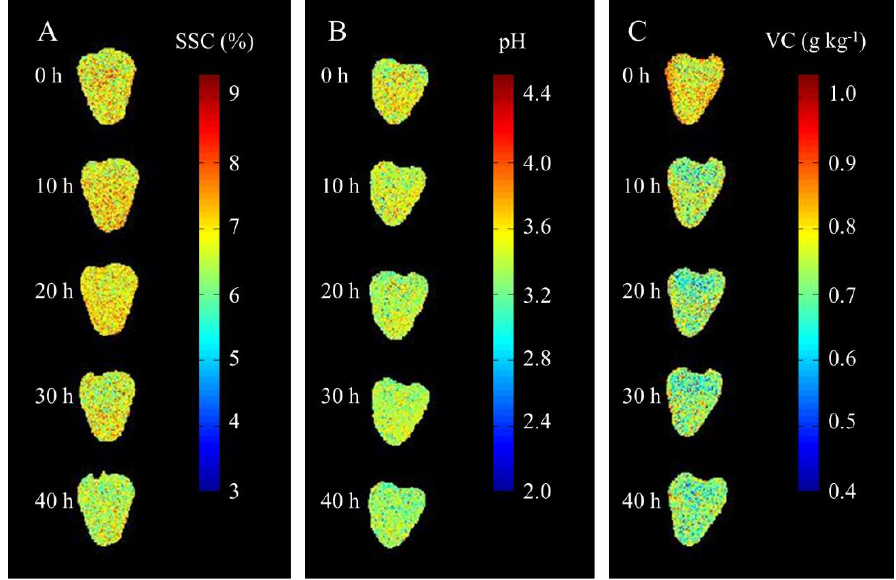
Figure 6. Distribution maps of SSC ( A ), pH ( B ), and VC ( C ) of strawberries during storage.